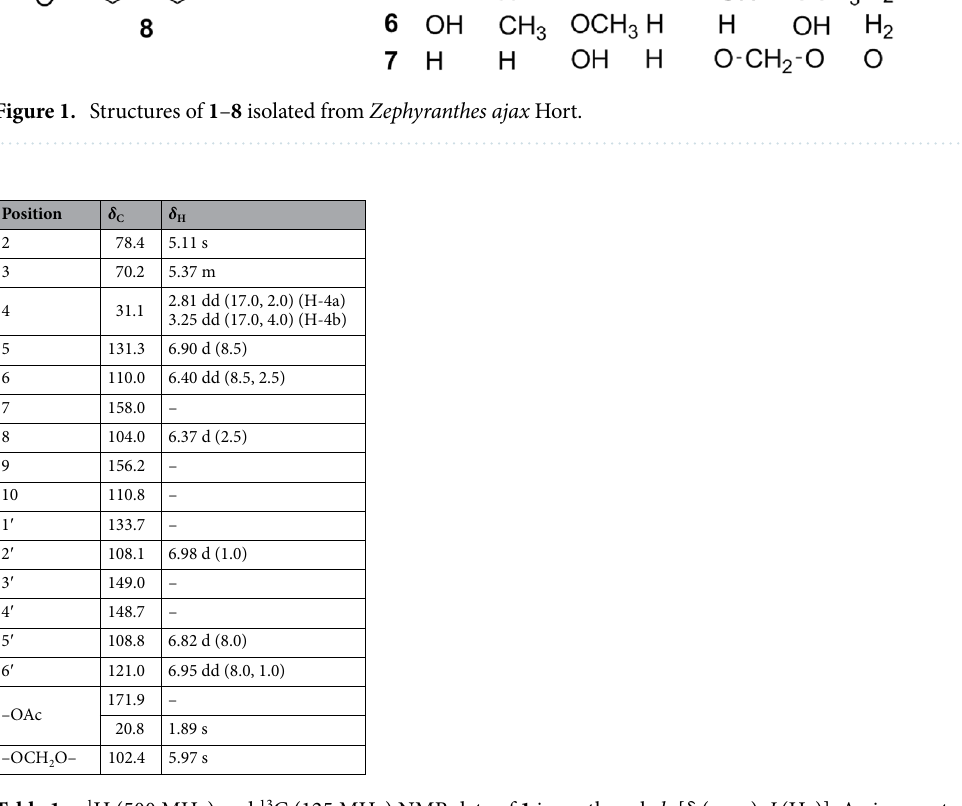
Table 1.. 1 H (500 MHz) and 13 C (125 MHz) NMR data of 1 in methanol- d 4 [δ (ppm), J (Hz)]. Assignments were done by HSQC, HMBC